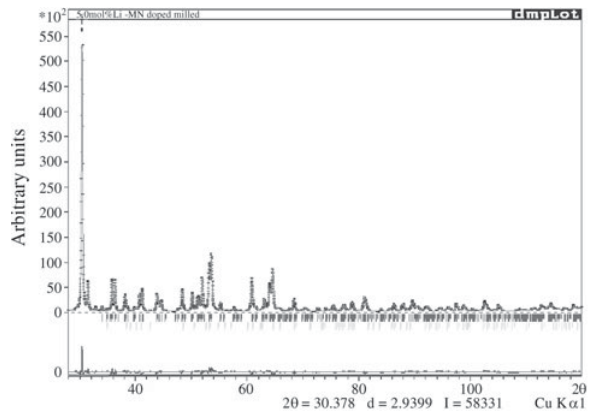
Figure 3. Rietveld graphic for L50 sample.